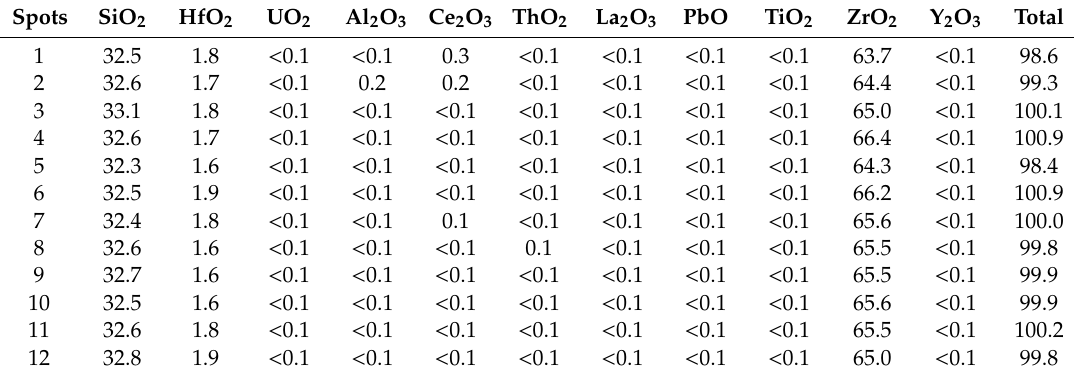
Table 2. Electron microprobe analyses (wt%) of the zircon from the quartz–allanite vein.